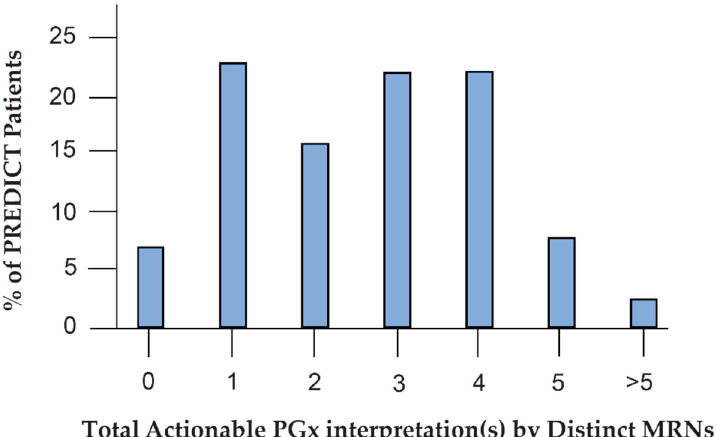
Figure 4. Reprocessing for SSRI content expansion increases drug–gene interaction risk. Thiopurines counted as a drug class instead of separate actionable PGx interpretations. Medical record number (MRN) was used as a surrogate for distinct patient count.